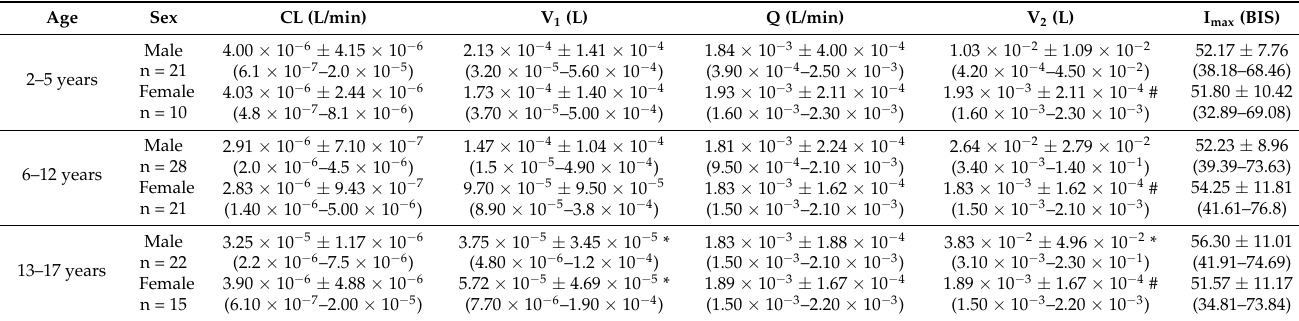
Table 2. Pharmacokinetic variables (CL, V 1 , Q, and V 2 ) and pharmacodynamics (I max ) by age range and